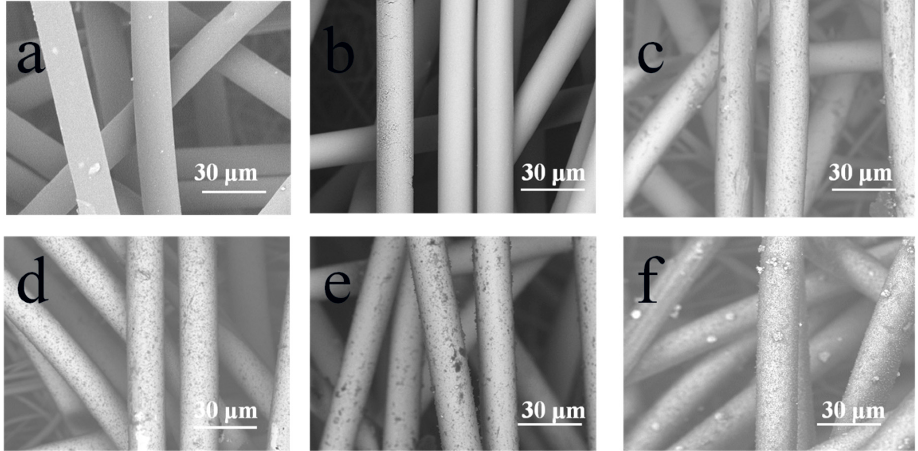
Figure 4. Surface morphology of fibers with PDA coating. ( a ) A blank PP nonwoven; ( b ) Ag-coated PP nonwoven; ( c ) PDA-treated (3 h) Ag-coated PP nonwoven; ( d ) PDA-treated (6 h) Ag-coated PP nonwoven; ( e ) PDA-treated (9 h) Ag-coated PP nonwoven; and ( f ) PDA-treated (12 h) Ag-coated PP nonwoven.